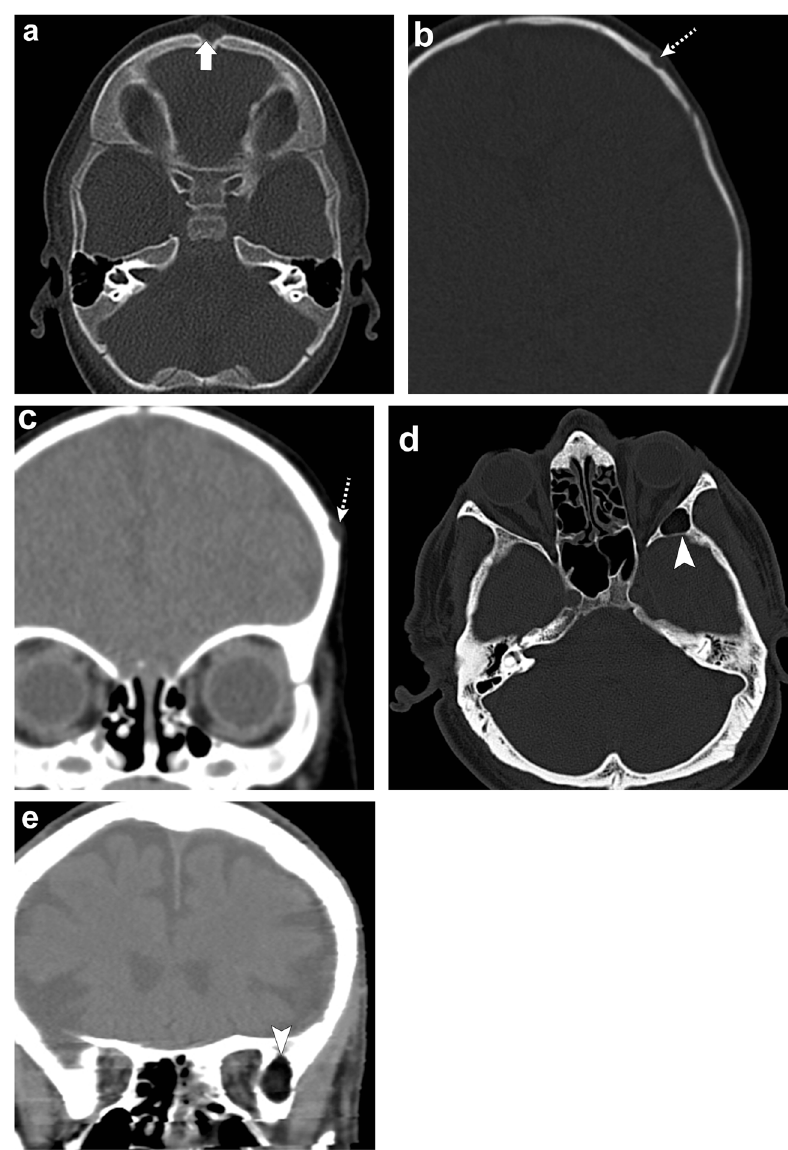
Fig. 14 Dermoid cysts. Patient 1: Axial head CT ( a ) depicts a midline fat-containing lesion in the frontal region ( thick arrow ). Patient 2: Axial bone window ( b ) and coronal soft tissue window head CT ( c ) show a dermoid cyst in the left frontal bone involving the outer table ( dashed arrows ). Patient 3: Axial CT ( d ) and coronal head CT portray a fat- containing lesion in the left grater wing of the sphenoid ( arrowheads